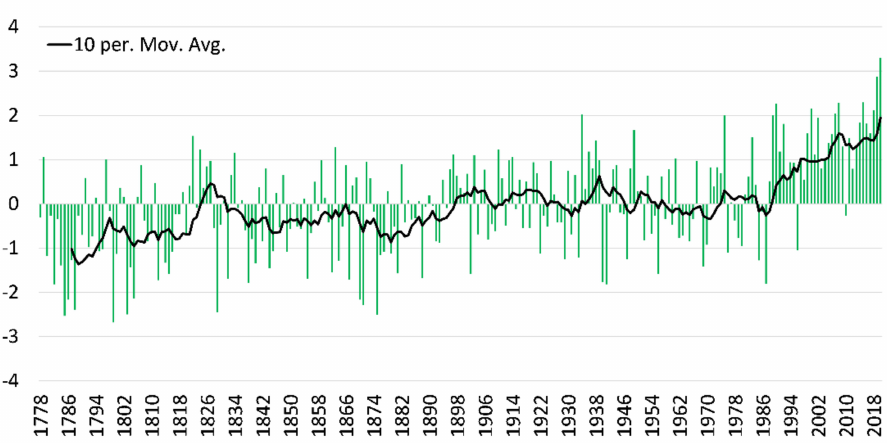
Figure 2. Anomalies of calculated (1781–1946) and observed (1947–2020) average annual temperature in Nida, ◦ C.